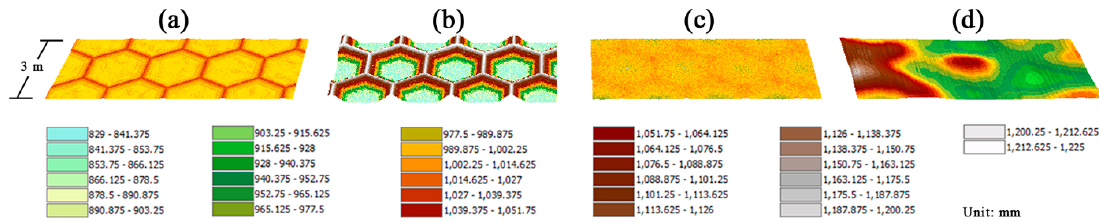
Figure 4. Numerical simulations of the four typical kinds of halite crust: ( a ) the flat crust starts to chap; ( b ) the honeycomb-shaped forms of crust; ( c ) compound polygon-structured crust eroded mainly by wind; ( d ) small mounded surface. These DEMs were created using a computer graphics method in an ideal situation, such that crack units of the salt crust are identical regular hexagons, expressed by a hypsometric tinting method. Each crust is modeled using the same 1000 mm height base to enable efficient comparison.